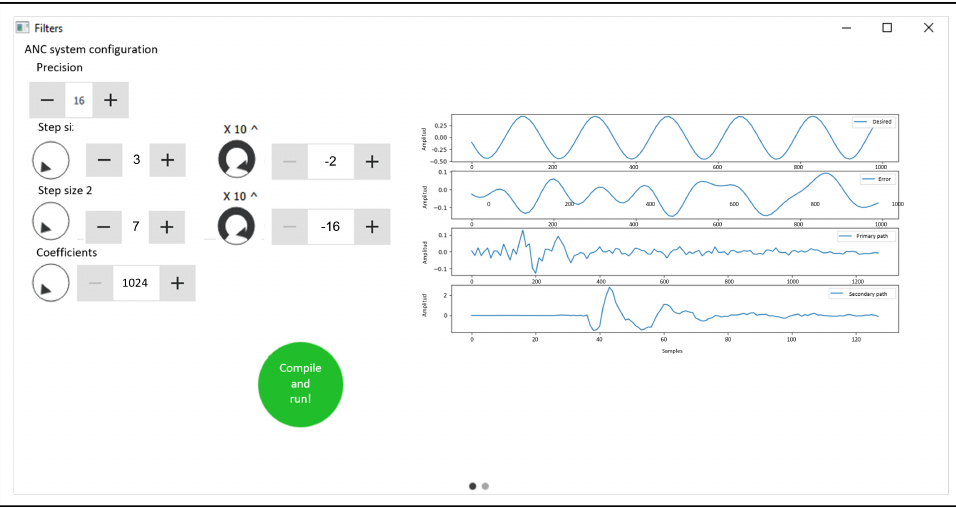
Figure 7. GUI main window.